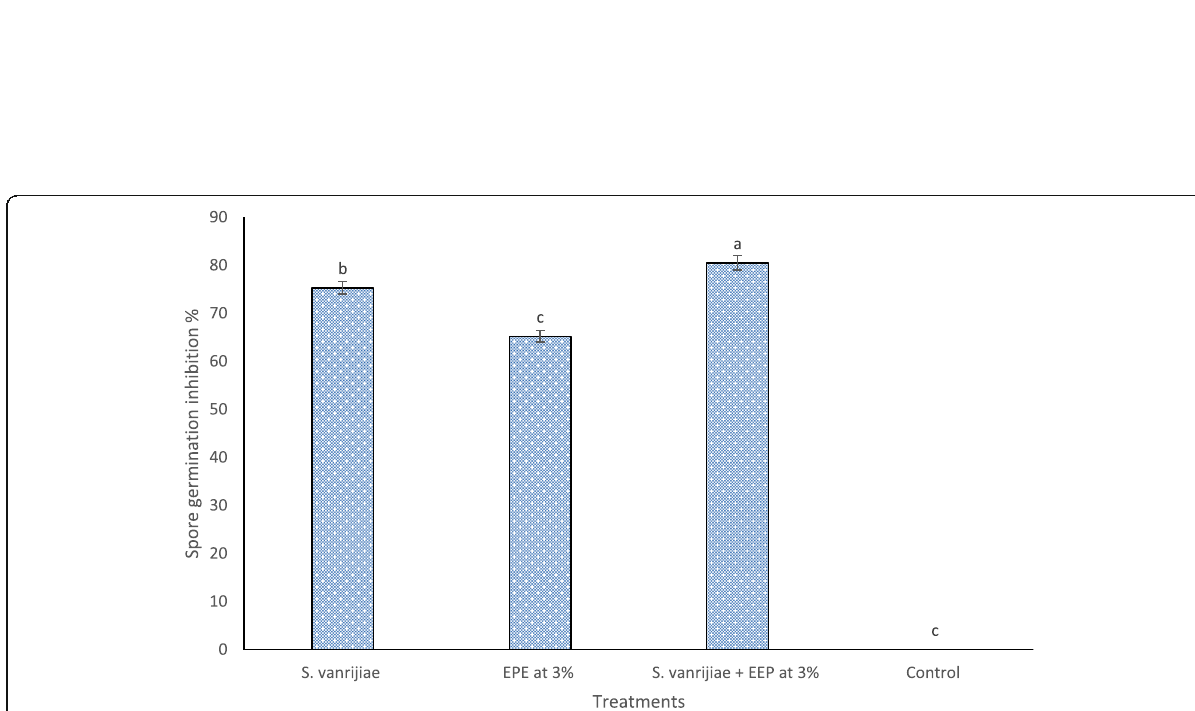
Fig. 2 Effect of S . vanrijiae , 3% EPE, and mixture on spore germination. Values in the column followed by different letters indicate significant differences among treatments according to lease significant differences test ( P =